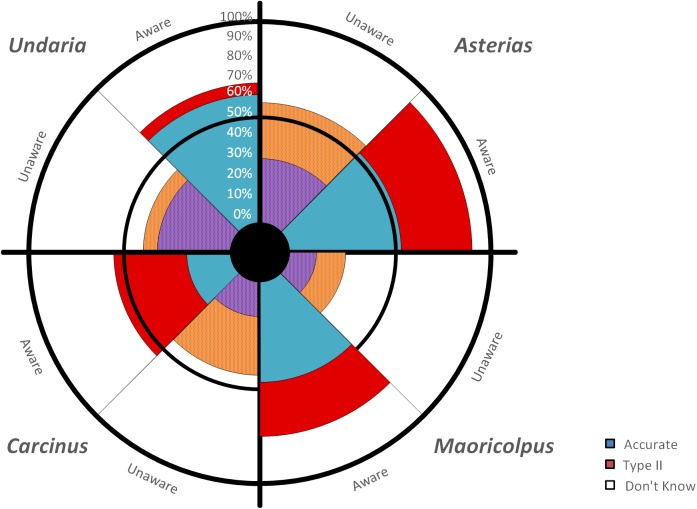
Respondent percentage of responses (accurate–blue; misidentification (Type II error)–red; “don’t know”—white) for each of the four selected NIMS (Undaria pinnatifida, Asterias amurensis, Maoricolpus roseus and Carcinus maenas); for “Aware” and “Unaware” groups.